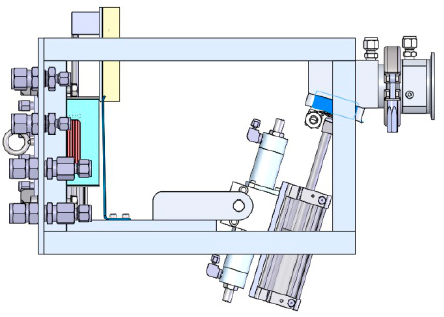
Figure 5. The target in irradiation position.